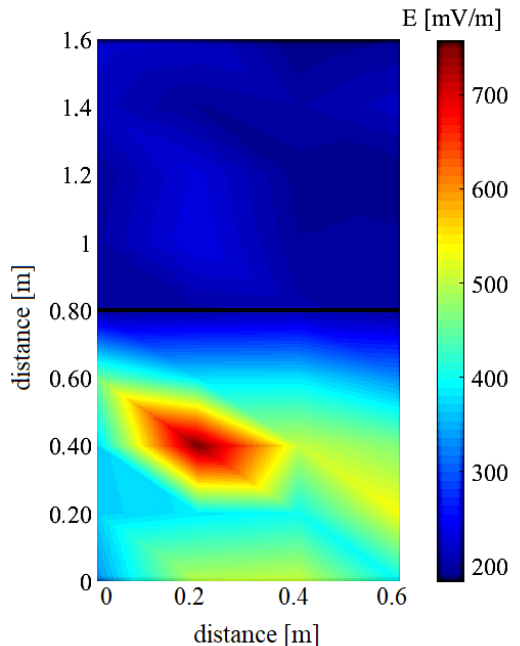
Figure 8. Experimental results: electric field strength spectrum in region of interest: f = 800 MHz. The line shows the border corridor/elevator.